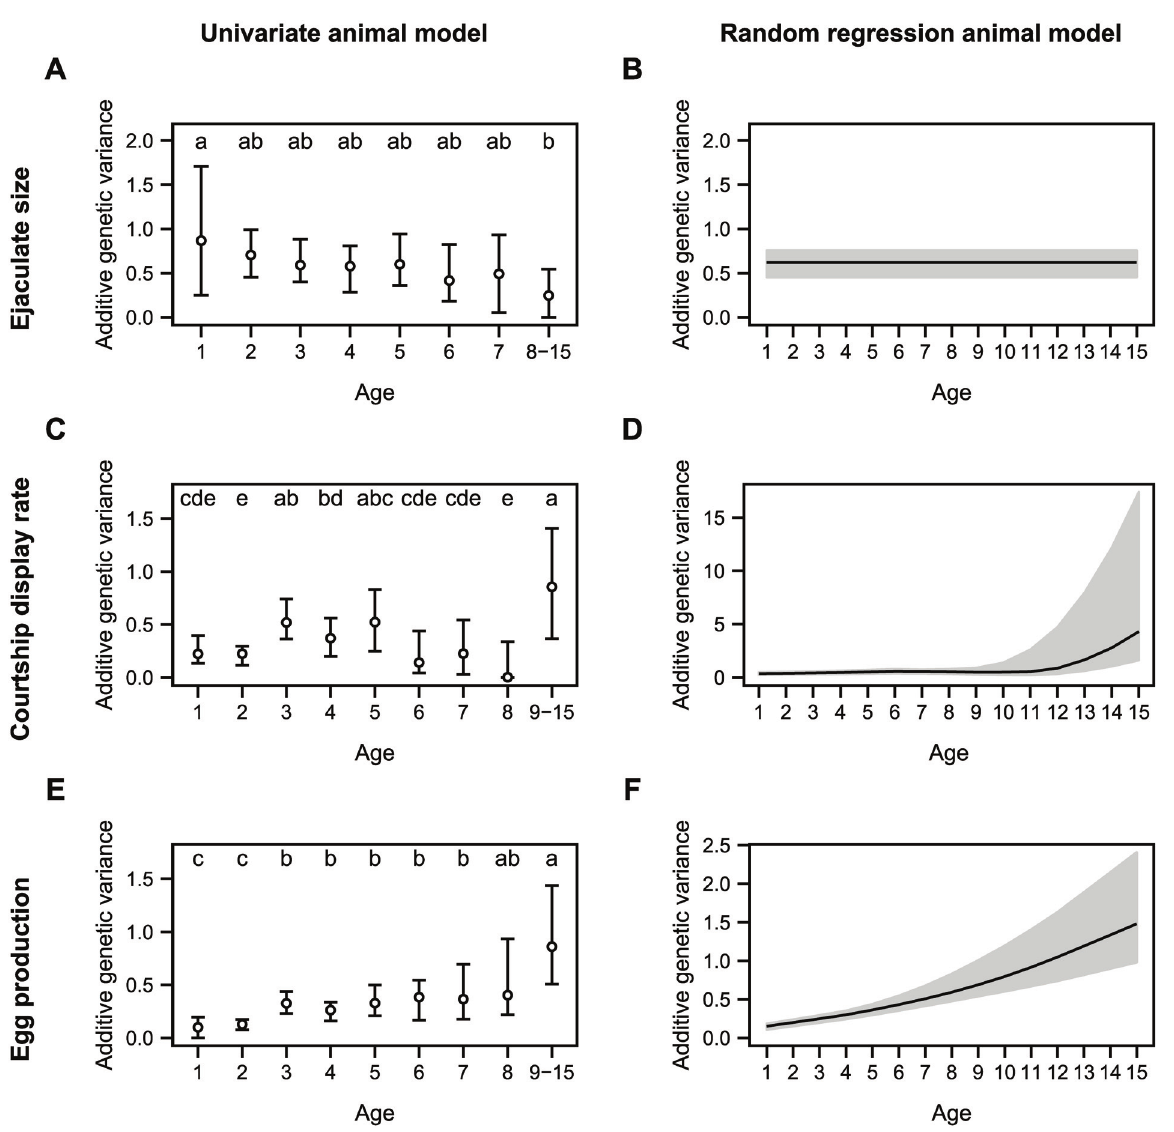
Fig 2. Variation of additive genetic variance across ages. Additive genetic variance was estimated using univariate animal models (left column) and random regression animal models (right column) for (A-B) ejaculate size, (C-D) courtship display rate and (E-F) egg production. For univariate animal models, circles represent the posterior mode estimation of additive genetic variance (with their 95% credible interval). Different letters represent significant differences between posterior estimates (see S2 Text for post-test details). For random regression animal models, the posterior mode estimates and their 95% credible interval are represented by black lines and associated grey area. All variance estimates are given on the latent scale and not back-transformed to the phenotypic scale. Variance estimates and fixed parameter estimates are provided in S1 and S2 Tables. Models were run using MCMCglmm package